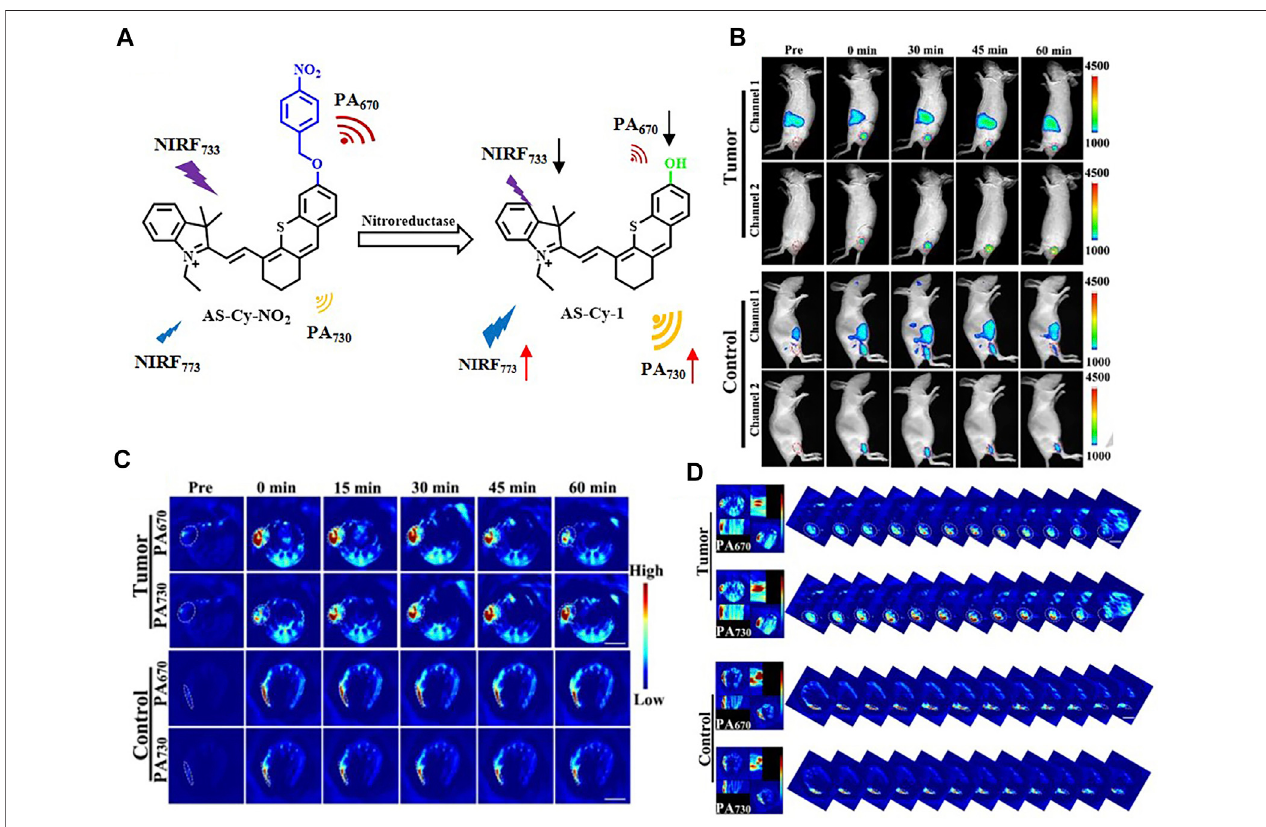
FIGURE 11 | (A) Mechanism of AS-Cy-NO 2 for noninvasively detecting NTR. (B) In vivo ratiometric fl uorescent imaging of AS-Cy-NO 2 for hypoxia in mice. (C) In vivo ratiometric PAI of 4T1 tumor bearing and the control hind limbs of nude mice postinjection with the AS-Cy-NO 2 . (D) Representative orthogonal-view 3D MSOT images covering the whole tumor region and the control hind limbs. Reproduced with permission from Zhang et al. (2022). Copyright 2022, Wiley-VCH.